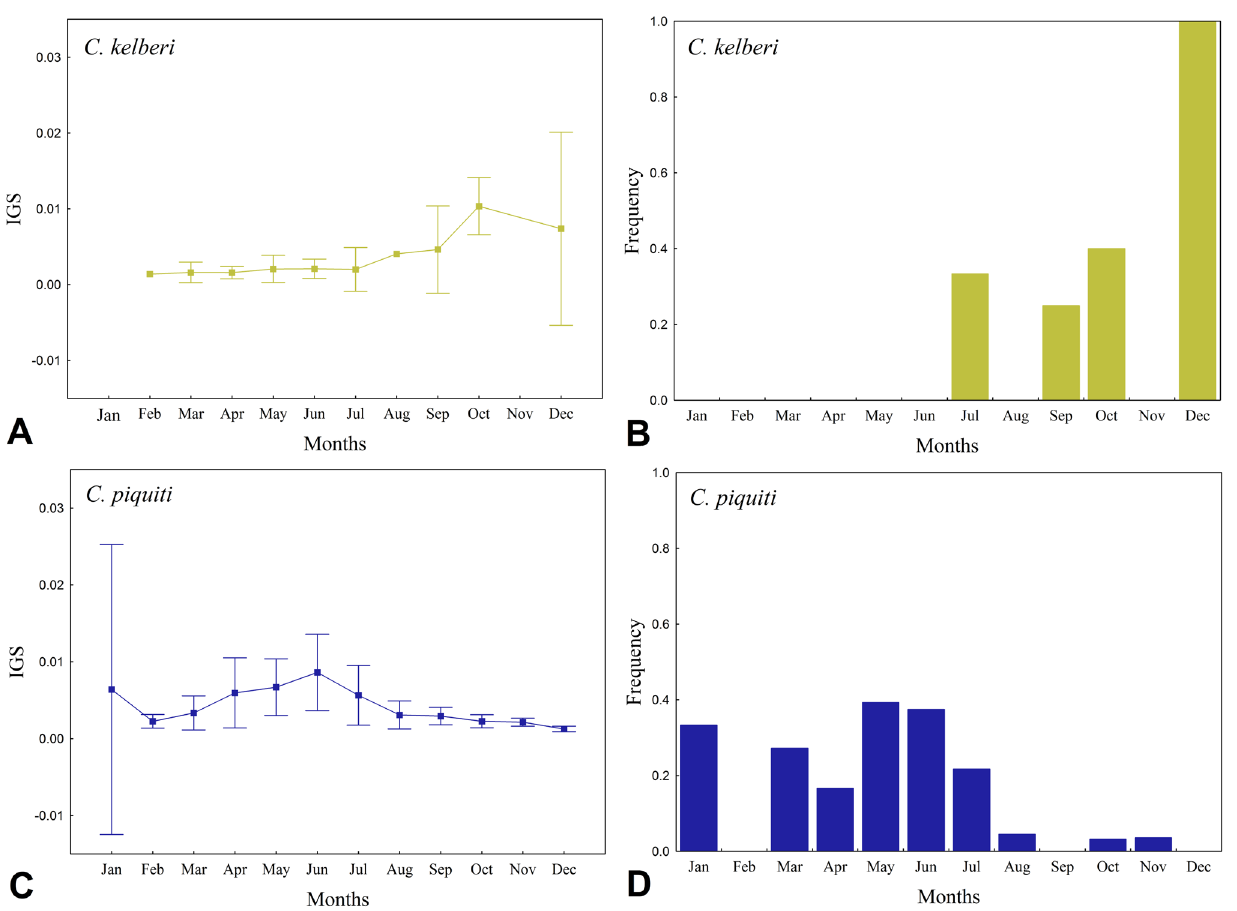
FIGURE 4 | Comparative reproductive ecology of Cichla kelberi and C. piquiti . Monthly variations in the gonadosomatic index (IGS) and in the frequency (%) of breeding females for C. kelberi ( A , B ) and C. piquiti ( C , D ).